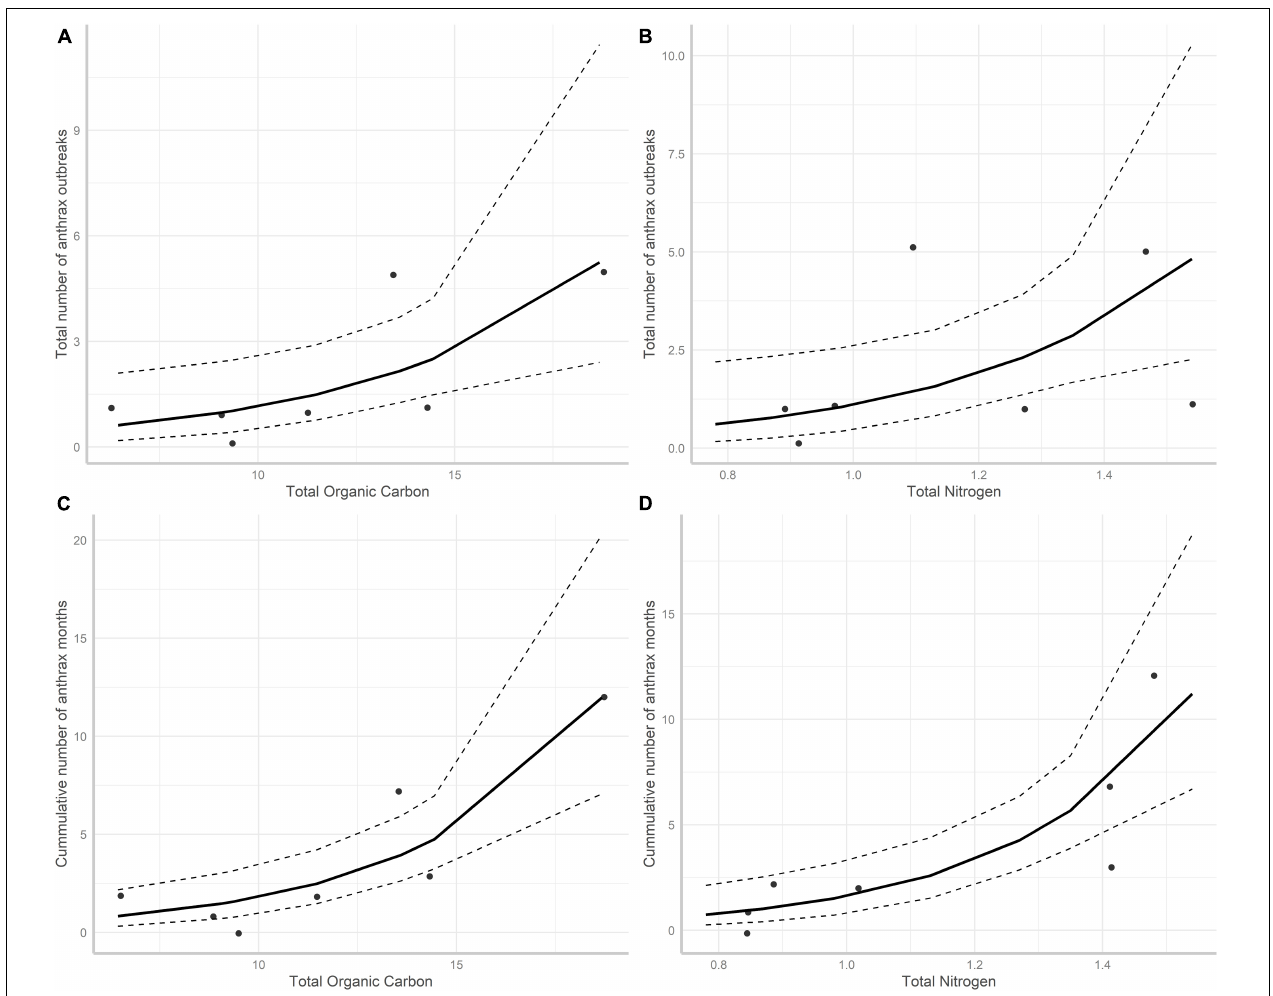
FIGURE 2 | The relationships between total organic carbon (g/kg − 1 ), total nitrogen (g/kg − 1 ), with the total number of anthrax outbreaks (A,B) and cumulative total months anthrax mortality was recorded (C,D) in Kenya’s wildlife focal areas. The predicted values and their confidence intervals were obtained from a Poisson GLM